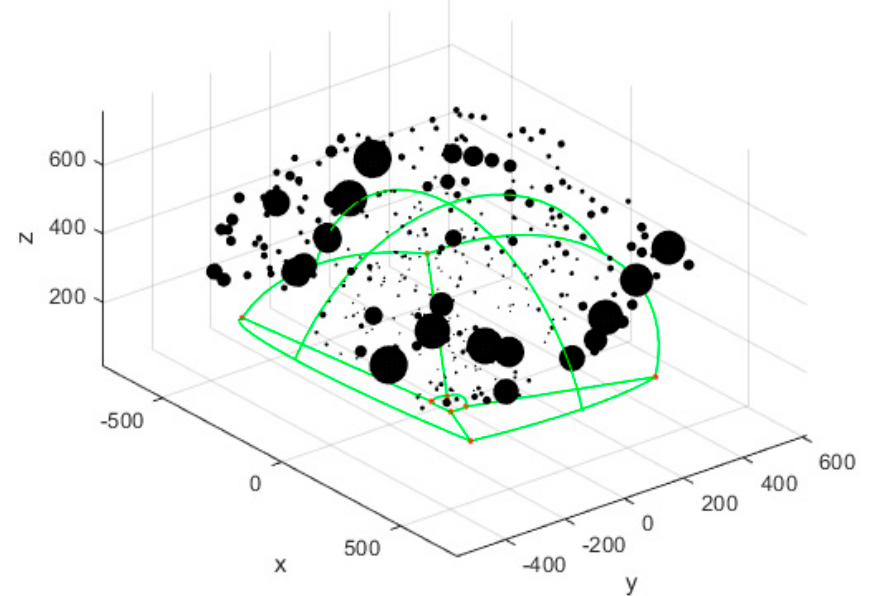
Figure 13. Up to 80 cm: overall view. X , y , and z axis are in mm.